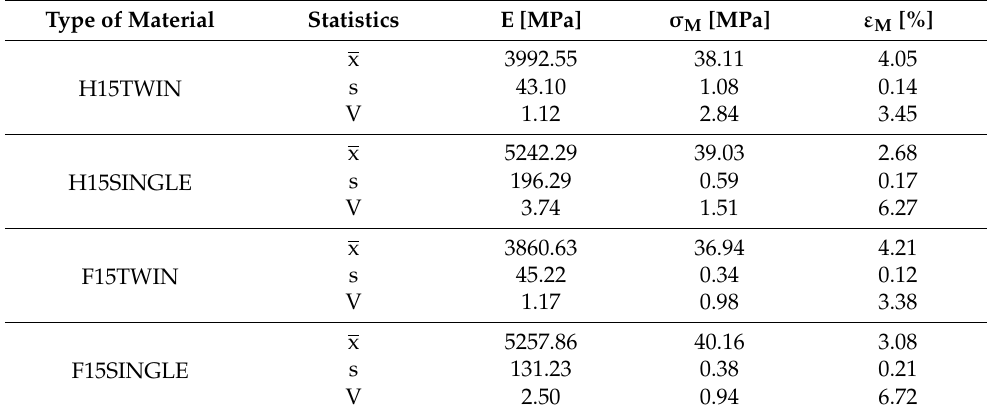
Table 8. The results of the static tensile test for biocomposites produced using single-screw and twin-screw extruders.